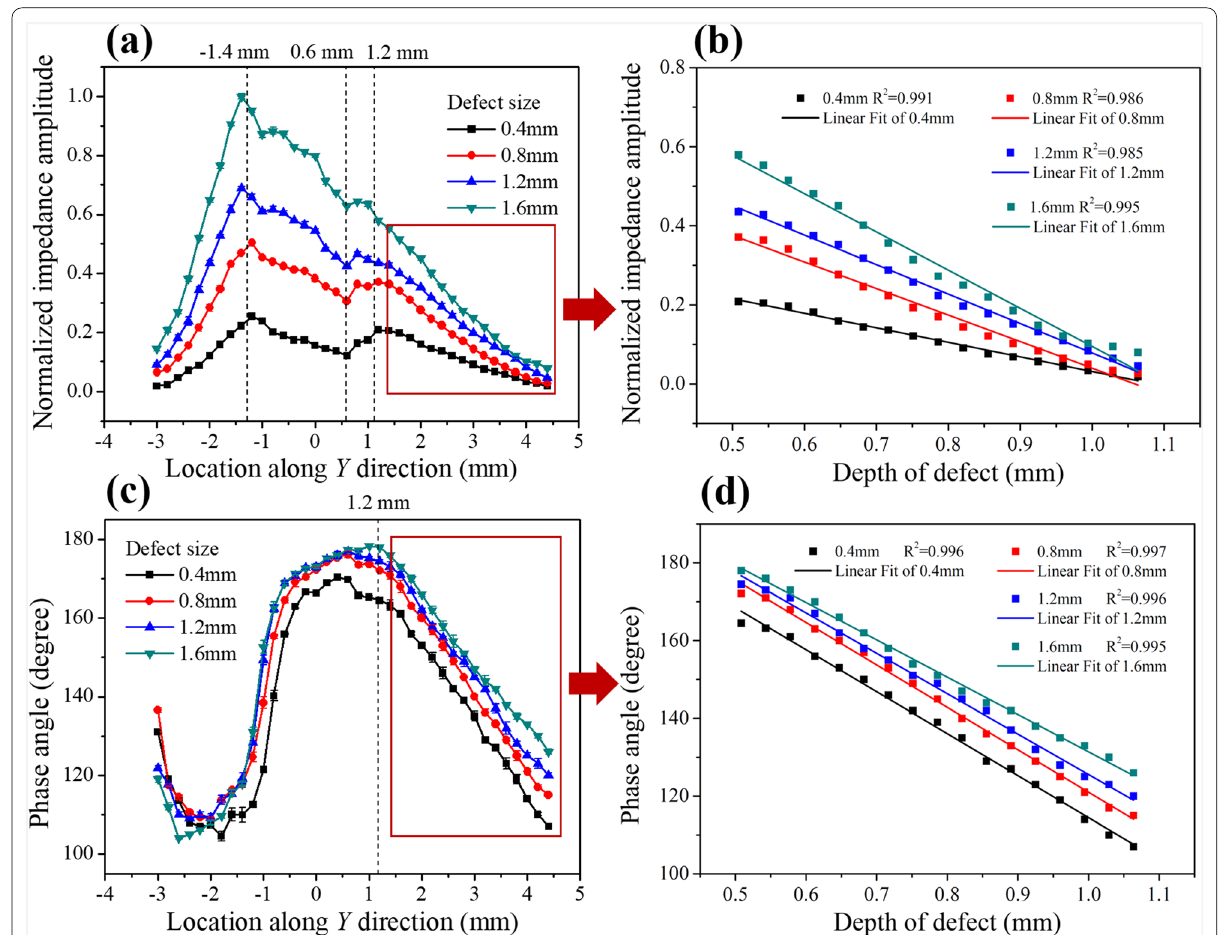
Figure 12 Relationship between scanning location and the normalized impedance amplitude ( a and b ), and the impedance phase angle of the captured defect EC signals ( c and d